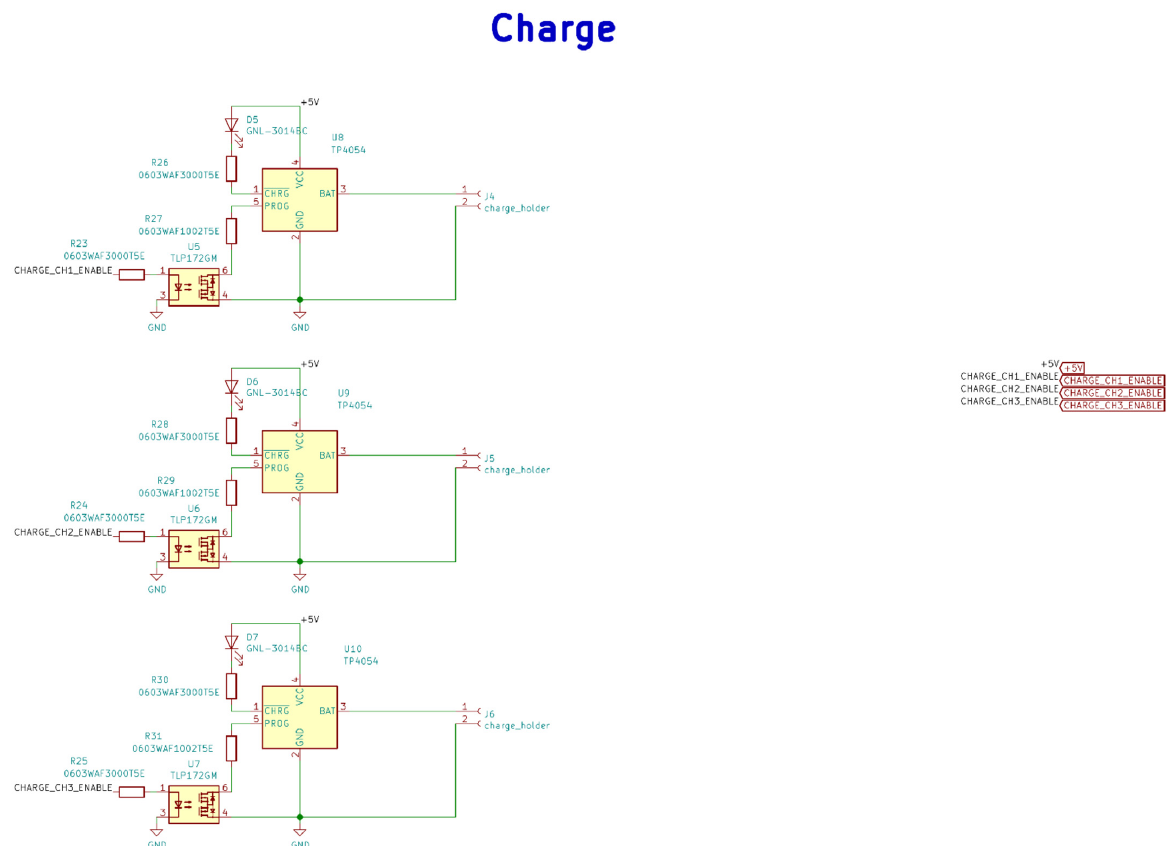
Figure A3. Electrical schematic diagrams of charging in the base station.